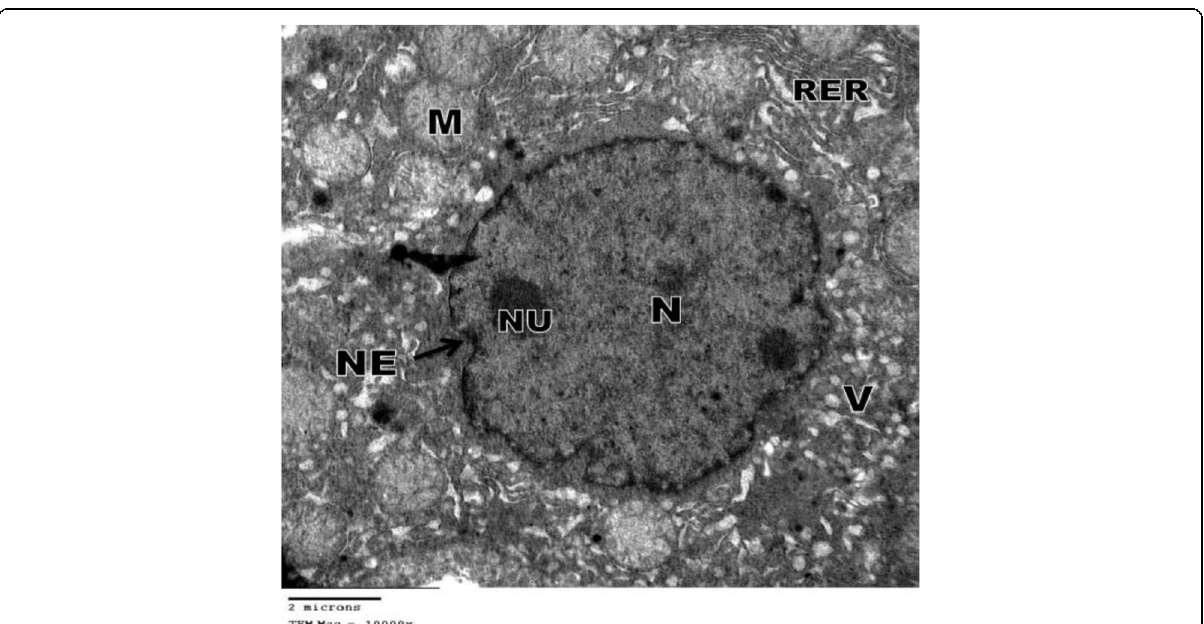
Fig. 28 An electron micrograph of a hepatocyte of treated mouse with Tamiflu (16 mg/kg b.wt.) in addition to Adamine (20 mg/kg b.wt.) for 10 days revealing swollen mitochondria (M), rough endoplasmic reticulum (RER), vacuoles (V), and nucleus (N) with irregular envelope (NE) and two nucleoli (Nu). (×